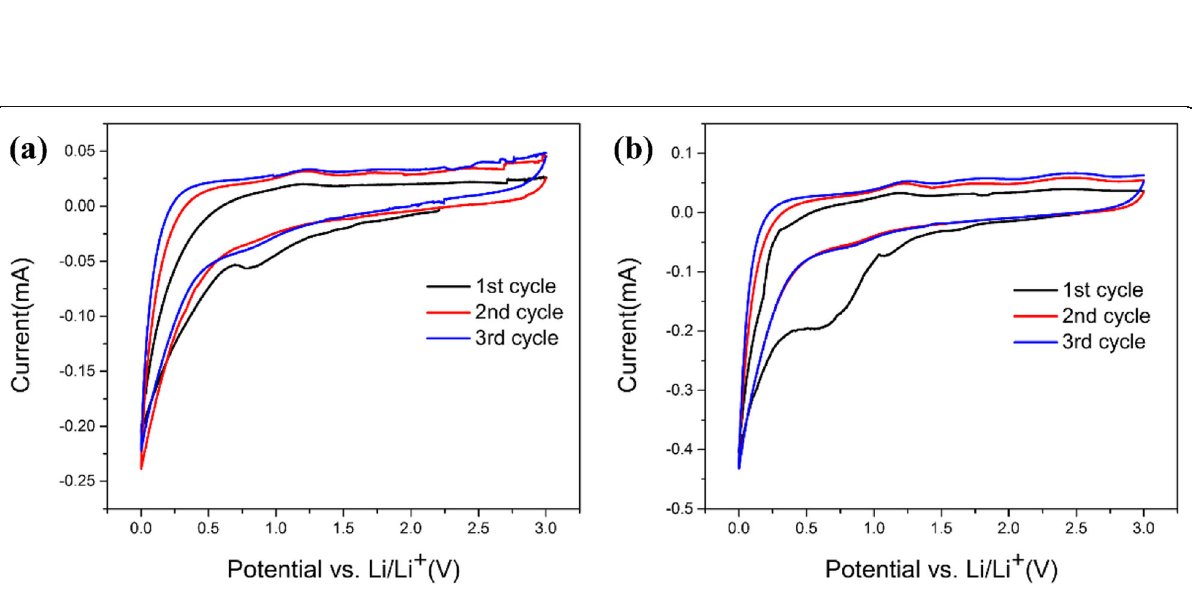
Fig. 7 a Cyclic voltammogram profiles of AC-500. b Cyclic voltammogram profiles of CAC-500